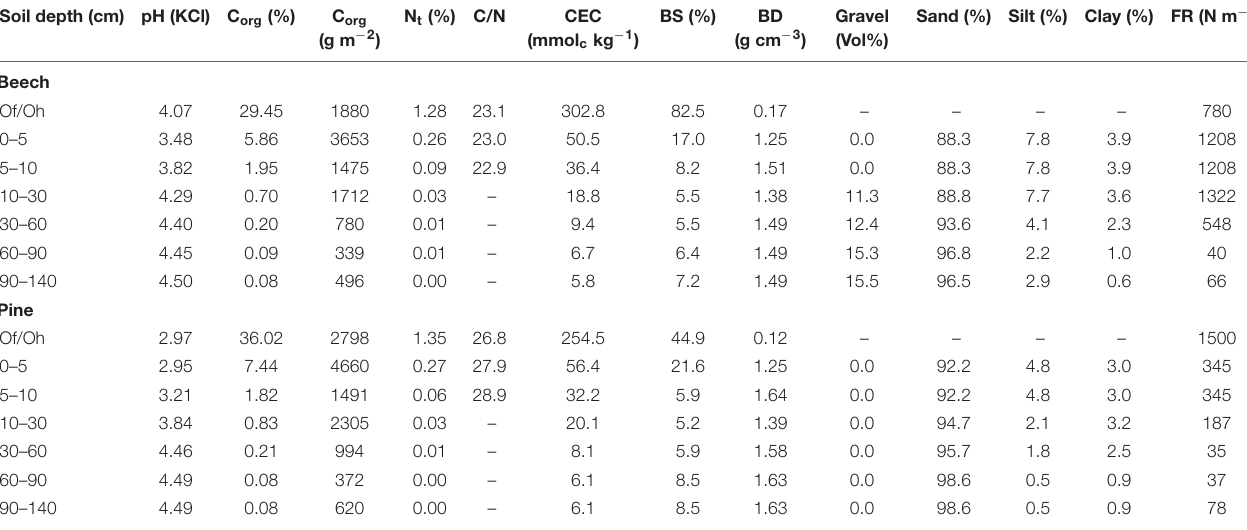
TABLE 1 | Soil physical and chemical properties of the beech stand and the pine stand. Soil depth (cm) pH (KCl) C org